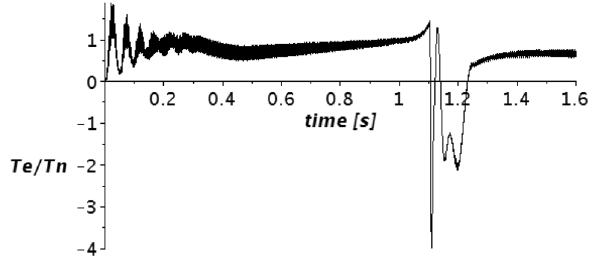
Fig. 24 Electromagnetic torque of the motor during the frequency starting with the linear frequency increase